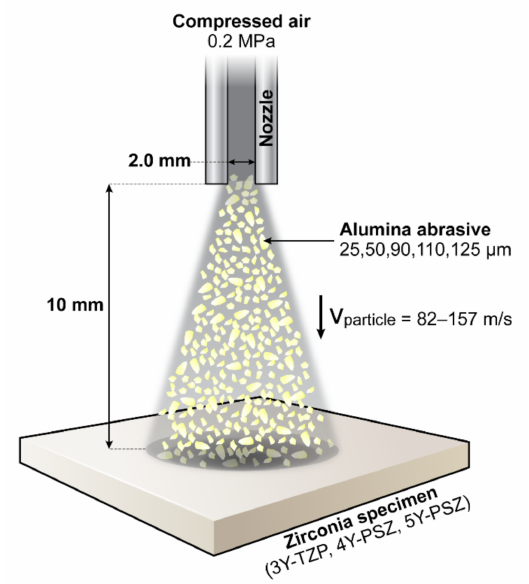
Figure 1. Schematic diagram of the sandblasting process; The alumina particles are accelerated towards the specimen with a high-pressure airflow through a circular nozzle (with a diameter of 2.0 mm). The alumina particles hit the specimen with a speed up to 157 m/s. 3Y-TZP: 3 mol% yttria-stabilized tetragonal zirconia polycrystal; 4Y-PSZ: 4 mol% partially-stabilized zirconia; 5Y-PSZ: 5 mol% partially-stabilized